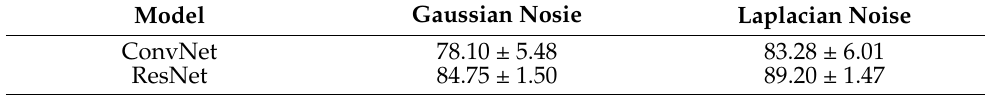
Table 5. The overall average accuracy of different neural networks (%).